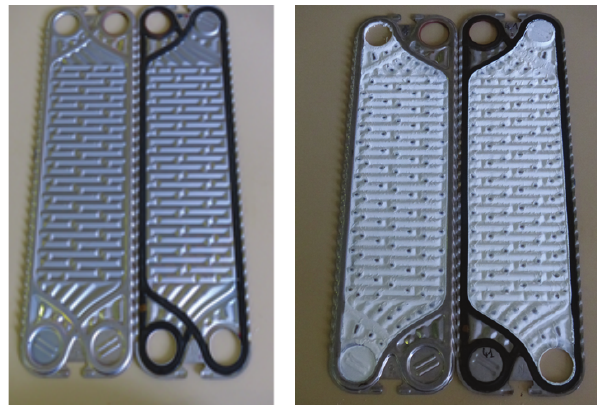
Figure6: Picturesof thedeposit collected onheat exchanger surface in the first and last channels of the